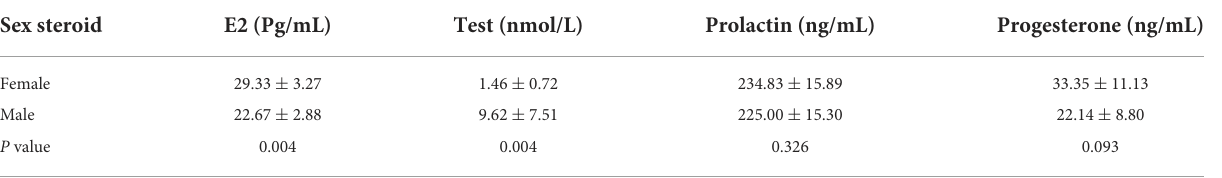
TABLE 1 Differences in serum sex steroid levels in mice ( ¯ X ± S , n =